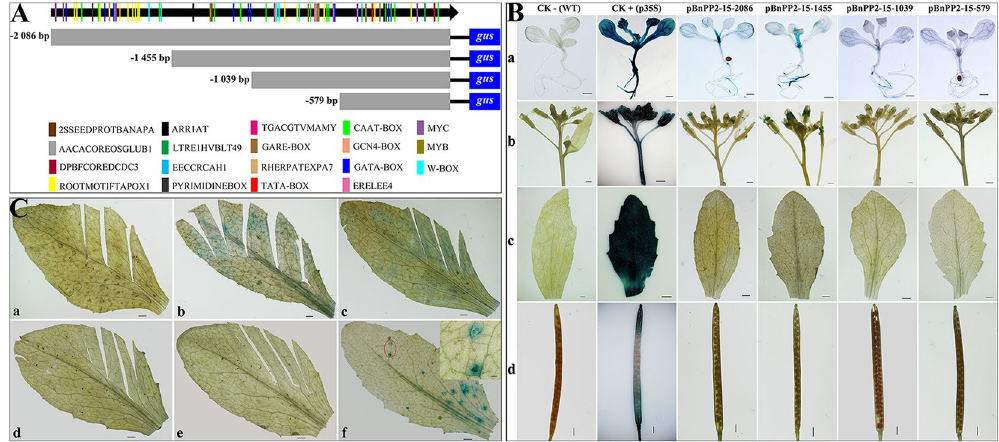
Figure 6. ( A ) Schematic diagram of truncated pBnPP2-15-2086 fused GUS constructs and distribution of cis -acting elements. The initiation codon was defined as + 1. The different elements were indicated by different color patches. The position of the scissors indicates the location of the truncation of the promoter. The numbers on the left indicated the length of 5 ′ - deletion fragments. ( B ) GUS histochemical assays in transgenic T3 Arabidopsis seedlings, flowers, mature leaves and siliques carrying pBnPP2-15-2086, pBnPP2-15-1455, pBnPP2-15-1039 and pBnPP2-15-579 constructs. CK − , wild-type; CK + , carrying CaMV 35S promoter constructs. a, b, c and d indicated seedlings, flowers, mature leaves and siliques, respectively. Bar = 0.1 mm. ( C ) GUS histochemical assays in mature leaves of transgenic T3 Arabidopsis under mechanical wounding and aphid infestation. a indicated leaf from wild-type for control; b, c, d and e indicated leaf from transgenic T3 Arabidopsis lines carrying pBnPP2-15-2086, pBnPP2-15-1455, pBnPP2-15-1039 and pBnPP2-15-579 constructs under mechanical wounding, respectively. f indicated transgenic T3 Arabidopsis lines carrying pBnPP2-15-2086 under aphid infestation. The red marker in Fig. 6Cf was enlarged in the upper right corner. Bar = 0.1